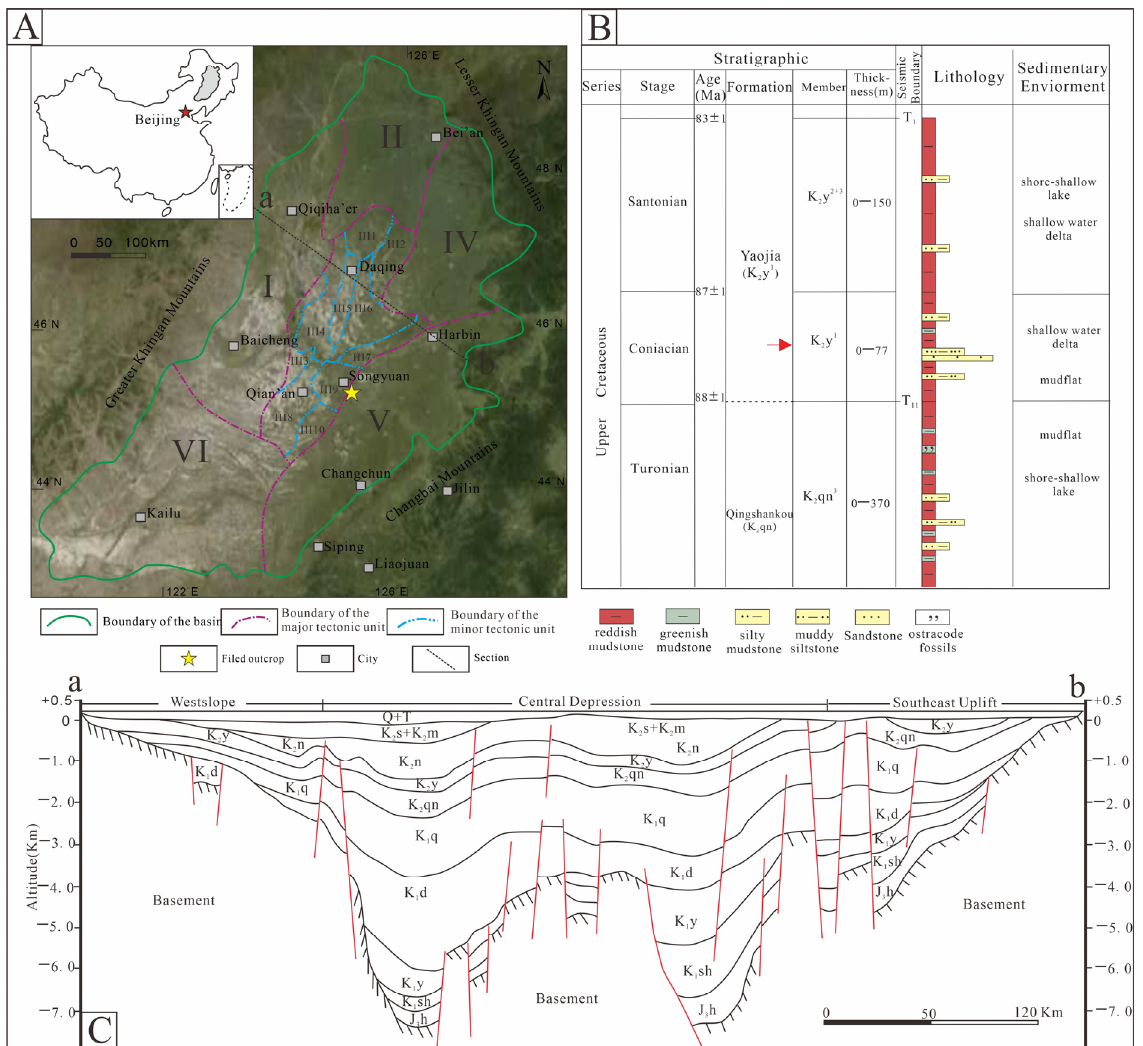
Figure 1. ( A ) Map showing tectonic units of the Songliao Basin and location of the field outcrops of K 2 y 1 . I, western slope zone; II, northern plunge zone; III, central depression zone; III1, Heiyupao Sag; III2, Mingshui Terrace; III3, Honggang Terrace; III4, Qijiagulong Sag; III5, Daqing Anticline; III6, Sanzhao Sag; III7, Chaoyanggou Terrace; III8, Changling Sag; III9, Fuyu Uplift; III10, Shuangtuozi Terrace; IV, northeastern uplift zone; V, southeastern uplift zone; VI, southwestern uplift zone. ( B ) Composite stratigraphic column of the Upper Cretaceous Yaojia Formation and Qingshankou Formation in the southern Songliao Basin (modified from [24,27,32] ). The red arrow shows K 2 y 1 , the focus in this study. ( C ) Geological section in NW-SE direction (modified from [10] ). See the location in ( A ).